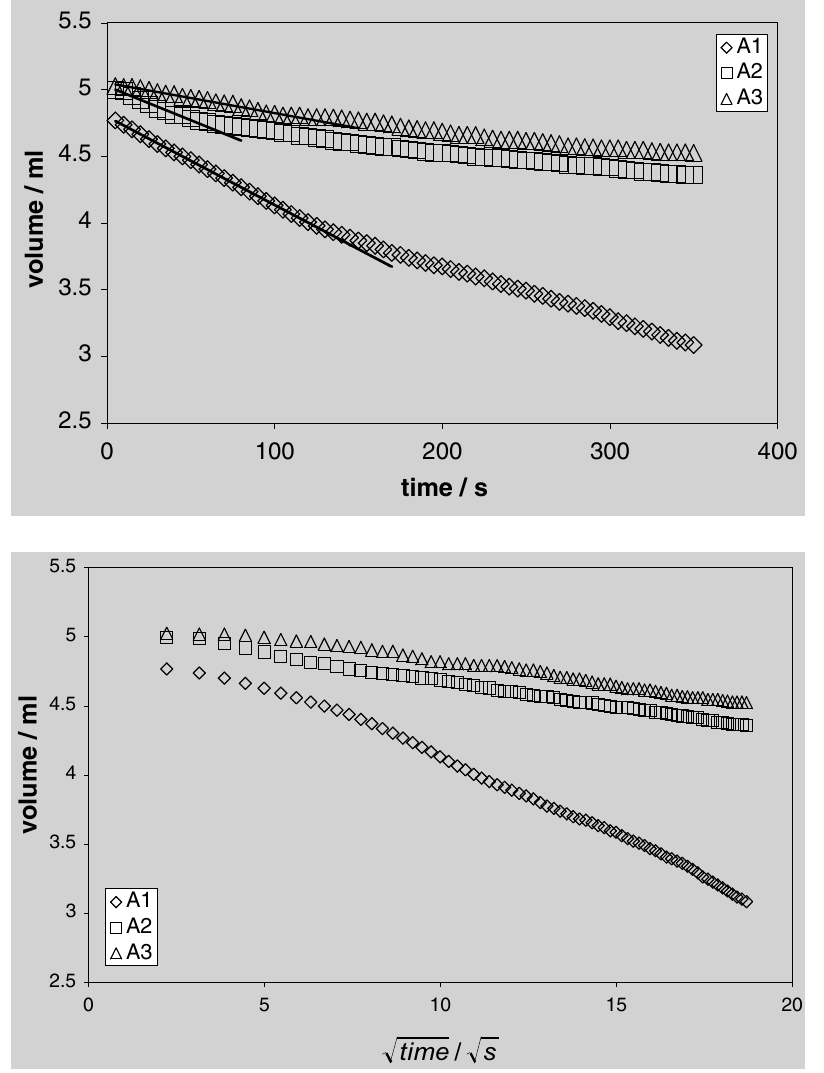
Figure 3: Dewatering behaviour of coating colours A1, A2 and A3. The initial slope, assessed as the initial dewatering rate is shown for all colours. Figure 3b shows the same data versus the square root of